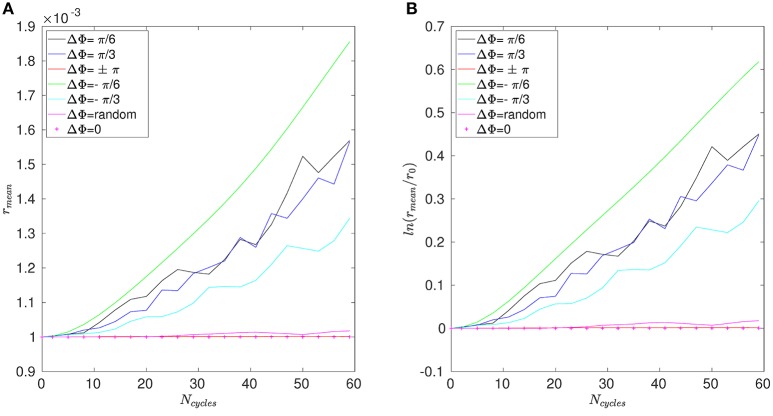
Results obtained for position C and Re = 5.10−2. (A) Average distance rmean between the fathers and the children as a function of the number of cycles Ncycles. (B) Logarithm of the dimensionless average distance rmean/r0 as a function of the number of cycles Ncycles.